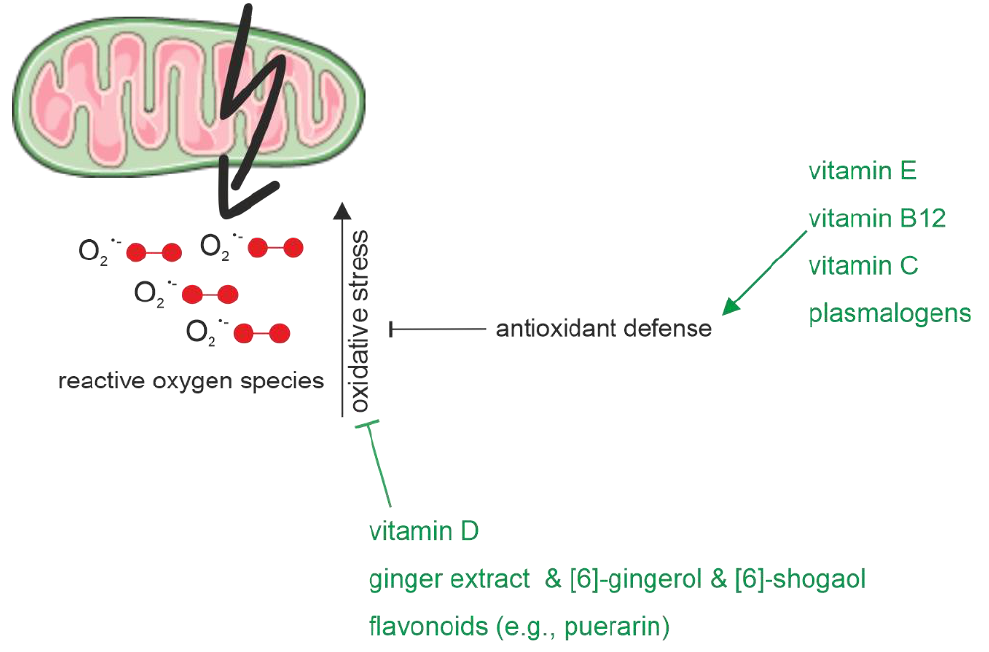
Figure 3. Influence of nutritional components on oxidative stress.